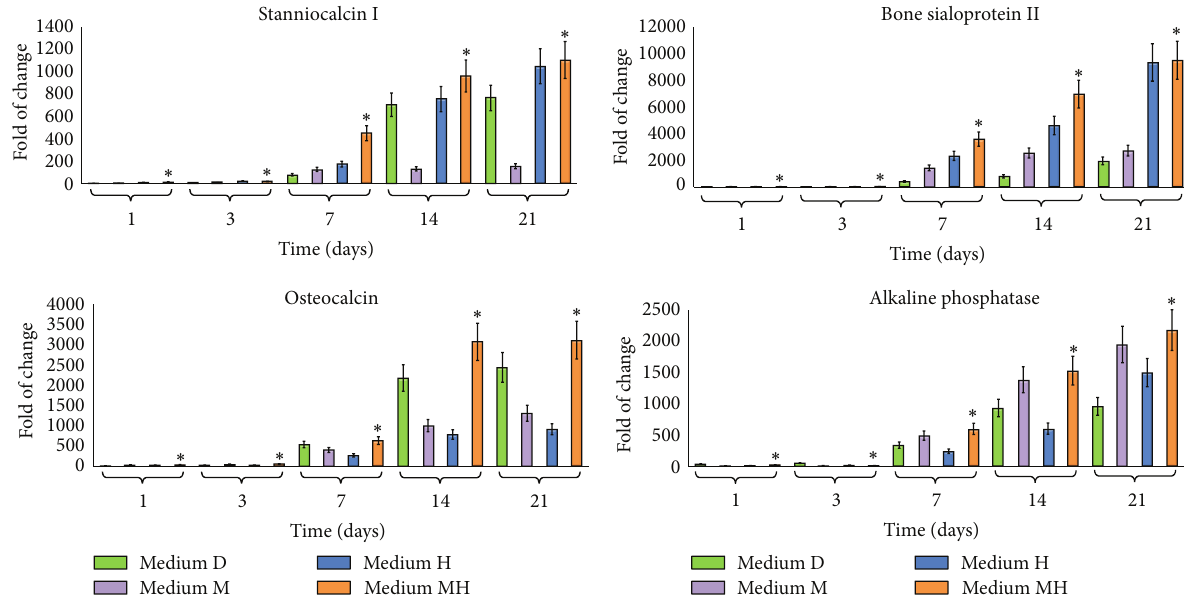
Figure 2: Effect of melatonin and HA + BU + RA on the expression of osteogenic specific genes. Cells were exposed for 1, 3, 7, 14, or 21 days in the presence of one of the 4 conditioned media described under Materials and Methods and based on 100 nM dexamethasone with 200 𝜇 M L-Ascorbic acid 2-phosphate (medium D), 0,01 M melatonin (medium M), or a mixture of HA 2 mg/mL + BU 5 mM + RA 1 𝜇 M (medium H) or on a combination of melatonin together with HA + BU + RA (medium MH) or kept at the undifferentiated state by growing on medium C. The amounts of stanniocalcin 1 (STC1), osteocalcin, bone sialoprotein II (BSPII), and alkaline phosphatase mRNA from treated or untreated cells were normalized to GAPDH, and the mRNA expression of cells differentiated with the 4 different conditioned media (D, M, H, and MH) was plotted at each time point as fold change relative to the expression in control undifferentiated cells, defined as 1 (mean ± SE; 𝑛 = 6 ). All data from medium D-treated cells, M-treated cells, medium H-treated cells, and medium MH-treated cells at each time point were significantly different from those in control undifferentiated cells. mRNA levels from cells that had been exposed to medium D, medium M, medium H, and medium MH were significantly different from each other at each time point. ∗ Significantly different from medium D-treated cells. Medium D: green bars, medium M: purple bars, medium H: blue bars, and medium MH: orange